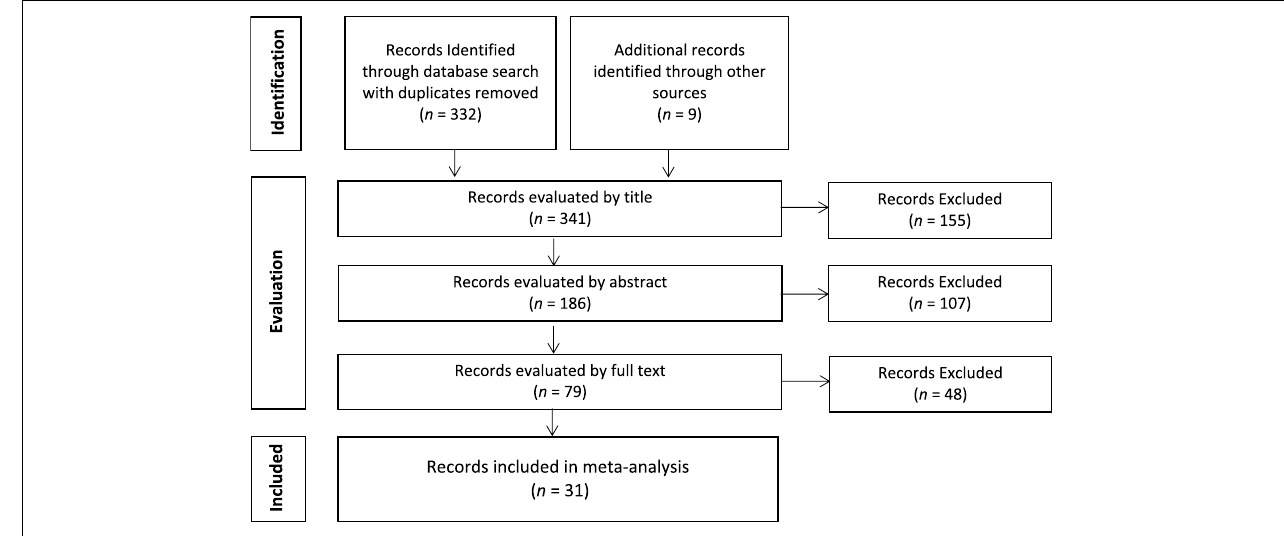
FIGURE 1 | Flow diagram for literature